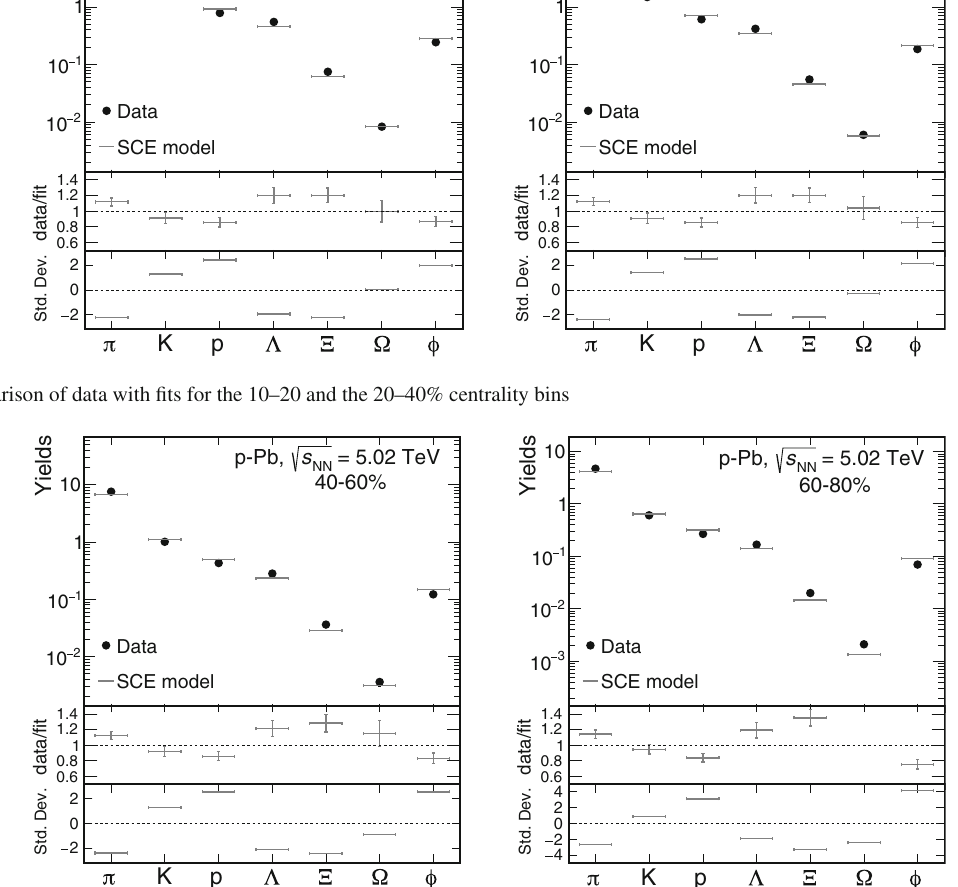
Fig. 4 Comparison of data with fits for 40–60 and the 60–80% centrality bins. Note that in the centrality bin 60–80% the (cid:8) has a Data/Fit ratio of 1.58 which no longer fits on the plot